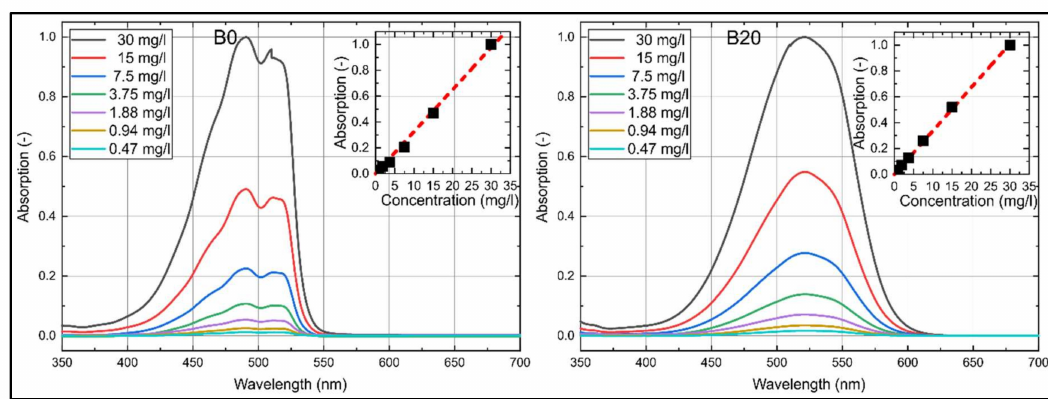
Figure2. Absorptionspectraofnilered( left : inn-decane(B0), right : inB20)normalizedtotherespective maximum intensity at 30 mg / L, inserted diagrams show linearity (B0: R 2 = 0.997, B20: R 2 = 0.999) of the integral LIF (laser-induced fluorescence) signal for various dye concentrations; 293 K.